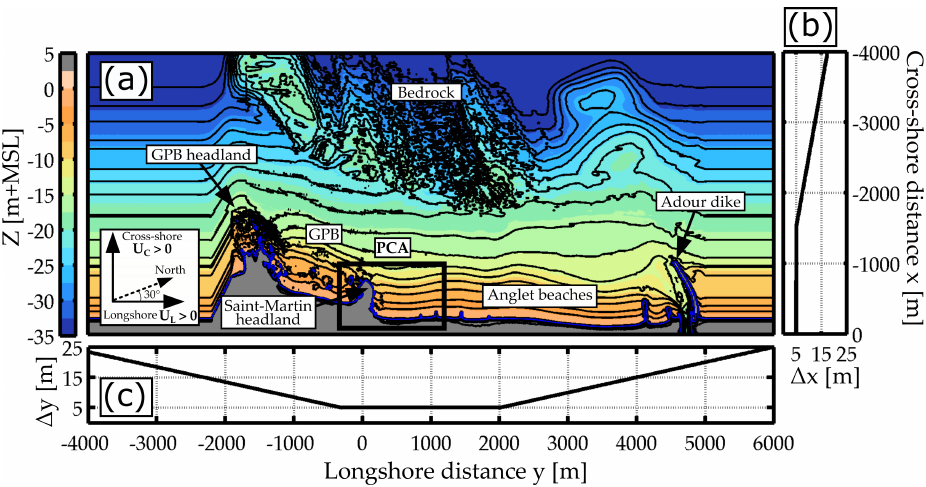
Figure 2. ( a ) Bathymetry used within the model. Colour indicates elevation (m + MSL), with the blue contour showing the MSL. Black contours are at 2-m separation. ( b , c ) show the cross-shore ( ∆ x ) and longshore ( ∆ y ) mesh step size,